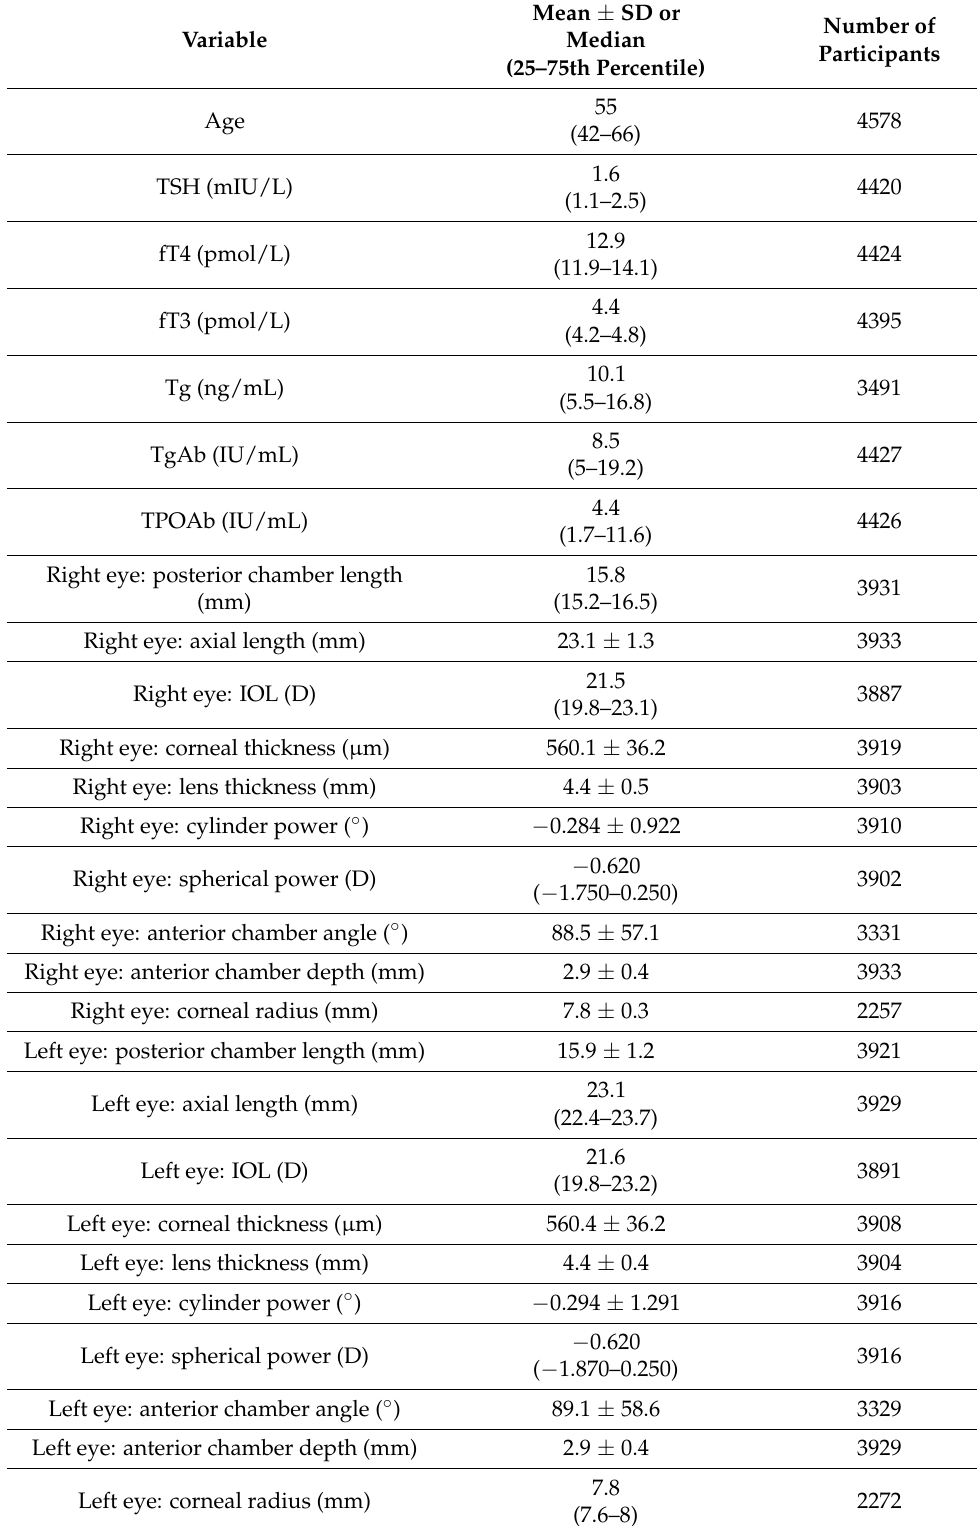
Table 1. Clinical characteristics of study